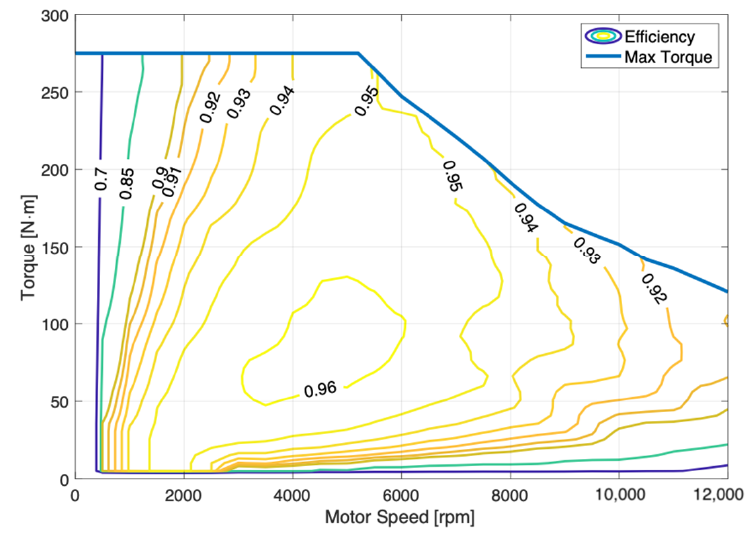
Figure 4. Single e-motor efficiency map.